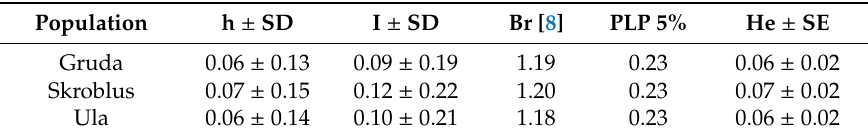
Table 1. The genetic diversity parameters of di ff erent Ranunculus sect. Batrachium populations. Band richness based on eight individuals (Br); polymorphic loci at the 5% level (PLP 5%); expected heterozygosity under Hardy–Weinberg genotypic proportions (He); gene diversity (h); Shannon’s information index (I); SD—standard deviation; SE—standard error.